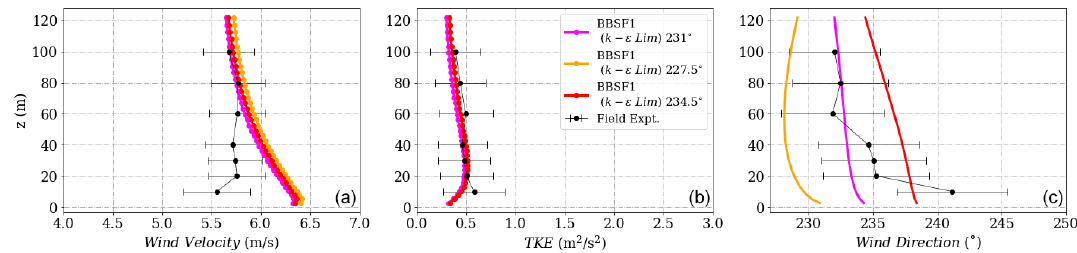
Figure D10. (a) Wind velocity magnitude, (b) wind direction and (c) turbulent kinetic energy tuned to reach calibration at height 573m corresponding to 100m at Tower 20 (tse04) for the BBSF model.